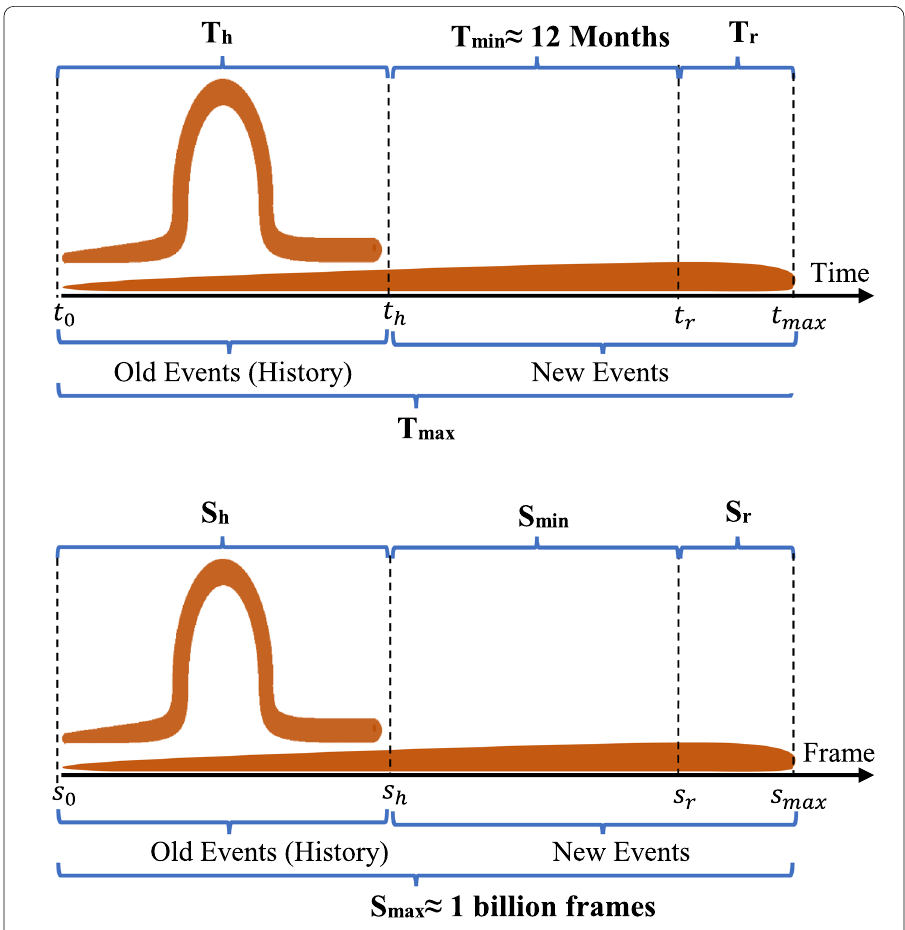
Fig. 10 Minimum and maximum length of the sliding window in expanding